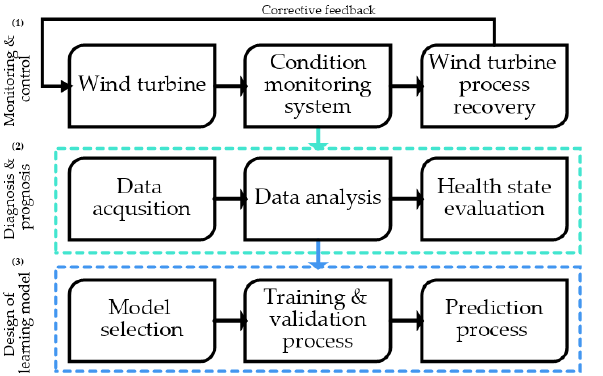
Figure 3. General solution of machine learning problems for wind turbine condition monitoring.